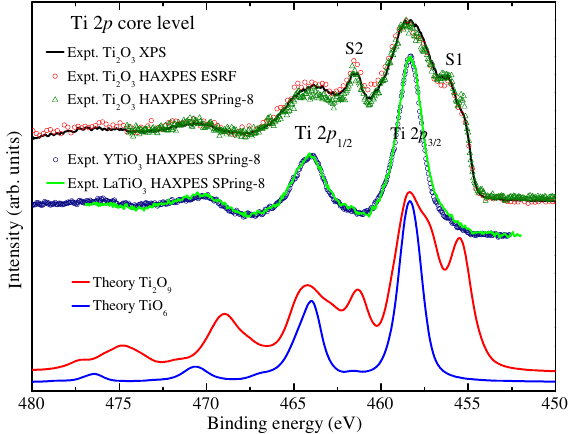
FIG. 2. Experimental Ti 2 p core-level photoemission spectra of Ti 2 O 3 taken at 300 K with h ν ¼ 1486 . 6 eV (black line, XPS), h ν ¼ 5931 eV (red circle, HAXPES ESRF), and h ν ≃ 6500 eV (dark-green triangle symbol, HAXPES SPring-8), and experi- mental Ti 2 p core-level photoemission spectra of YTiO 3 taken at 300 K (navy circle) and of LaTiO 3 taken at 200 K (green line) with h ν ≃ 6500 eV (HAXPES SPring-8). Also shown are the theoretical configuration-interaction calculations using the TiO 6 (blue line) and the Ti 2 O 9 (red line) clusters; see